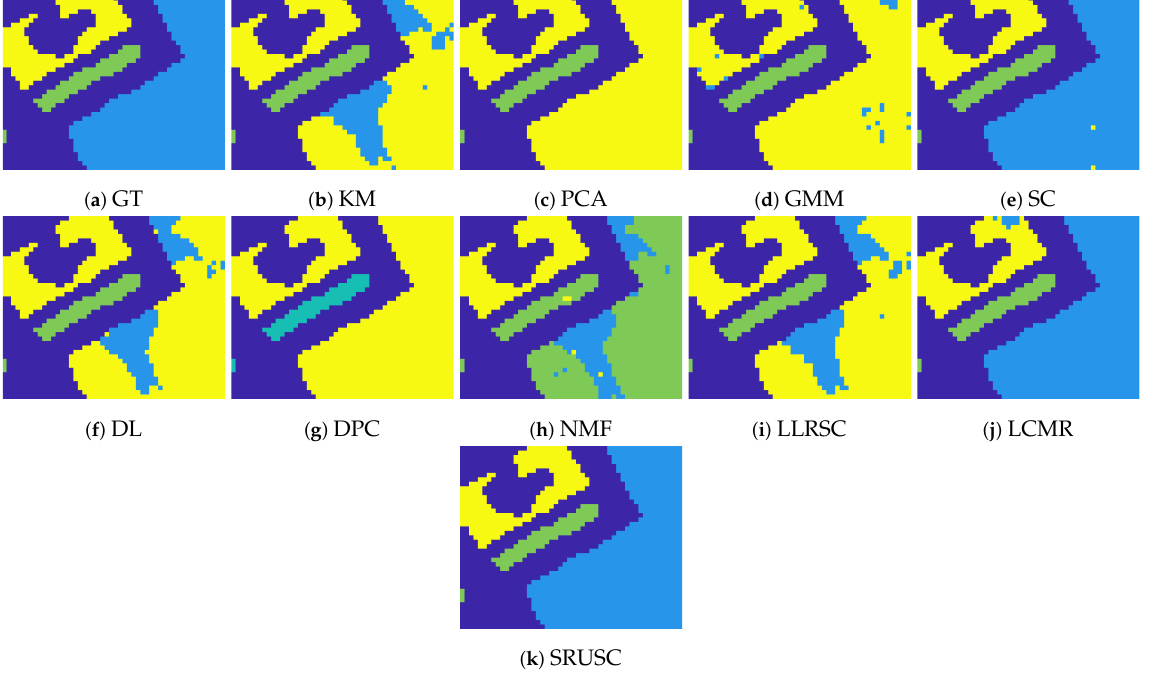
Figure 11. On the Pavia U data set, only the proposed method achieves perfect accuracy, though Euclidean spectral clustering and LCMR perform well. Moreover, SRUSC correctly estimates K = 3 for this example; see Figure 12. This is a further advantage of SRUSC over SC (which fails to estimate K correctly) and LCMR (which is